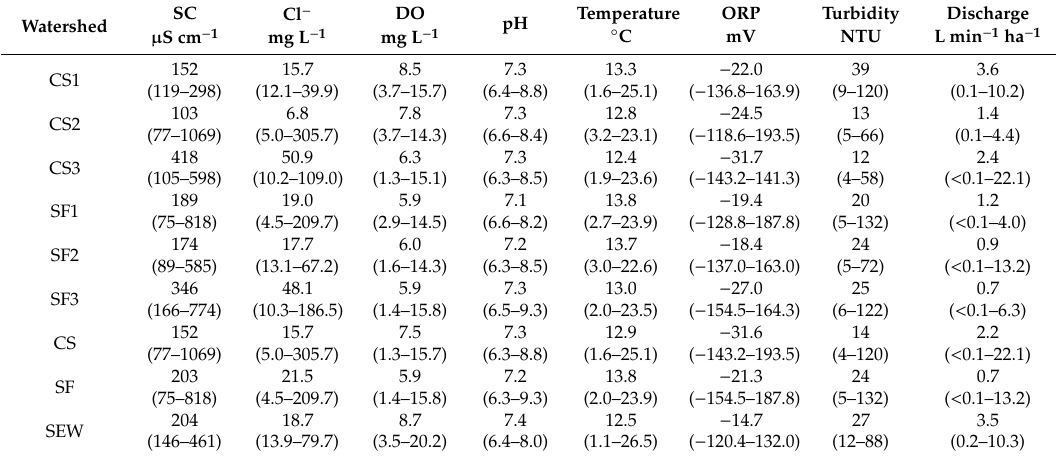
Table 3. Median (range) of environmental parameters and stream discharge at watershed outlets. SC = specificconductance; Cl − = chloride; DO = dissolvedoxygen; ORP =